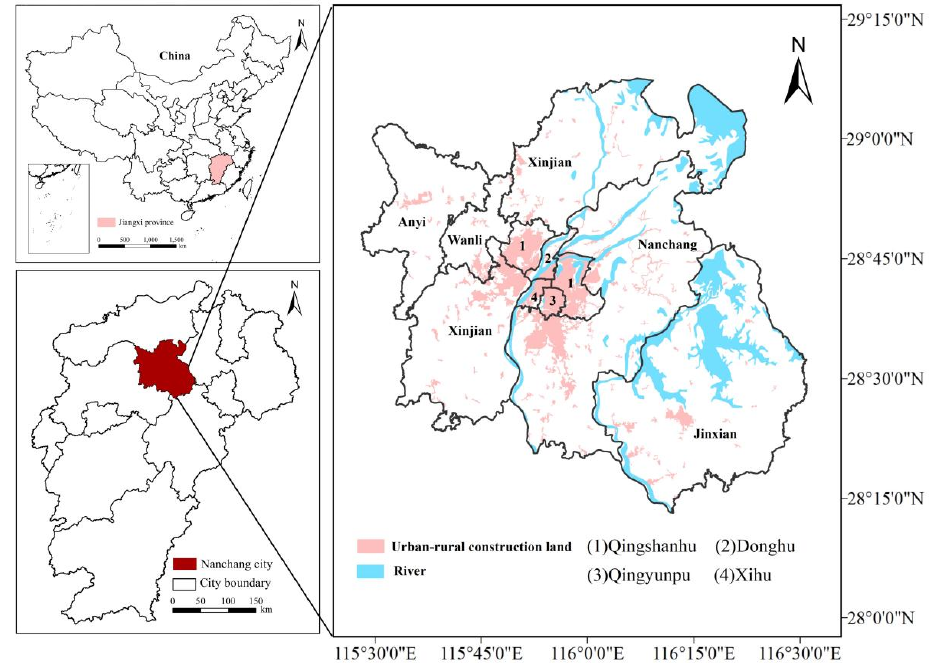
Figure 1. Geographical location of the study region—Nanchang City, Jiangxi Province, China.